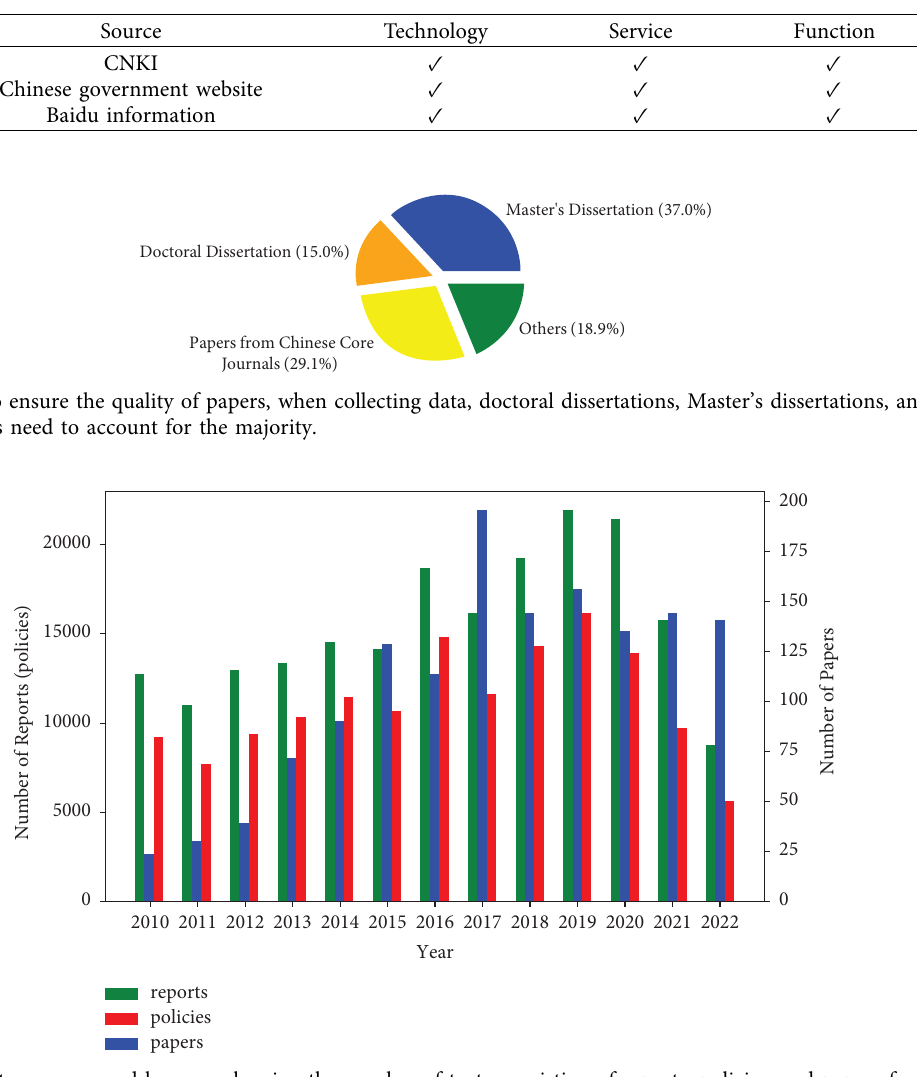
Table 1: Available data and sources are as follows.